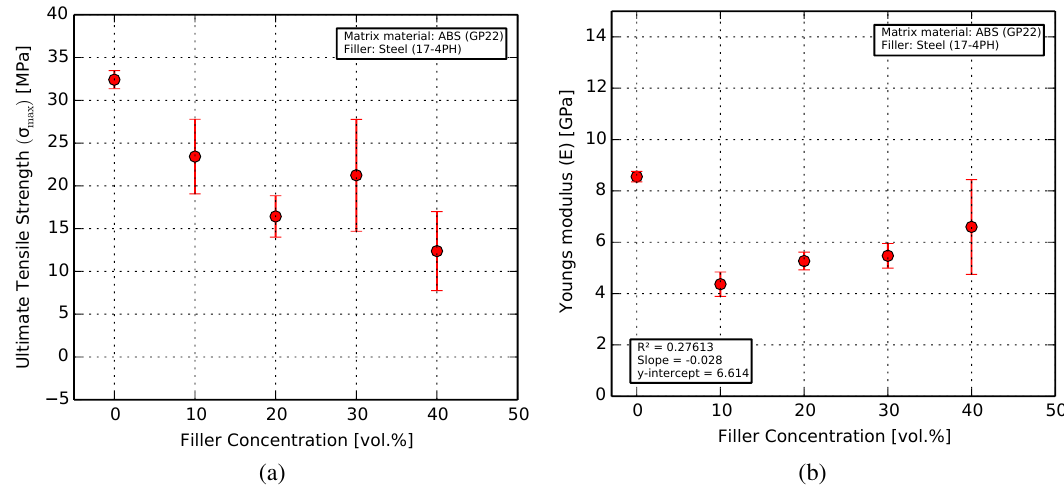
Figure 6. Results from the tensile characterization showing ( a ) the ultimate tensile strength decreasing by up to 61% compared to pure ABS; and ( b ) the Young’s modulus decreasing by about 50% for the 10vol. %